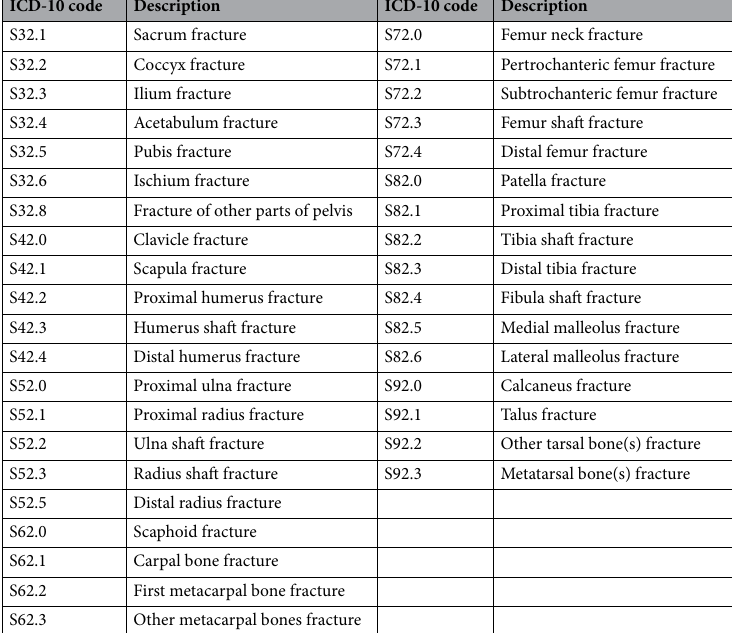
Table 1. Used ICD-10 code to calculate total numbers of fractures with descriptions.